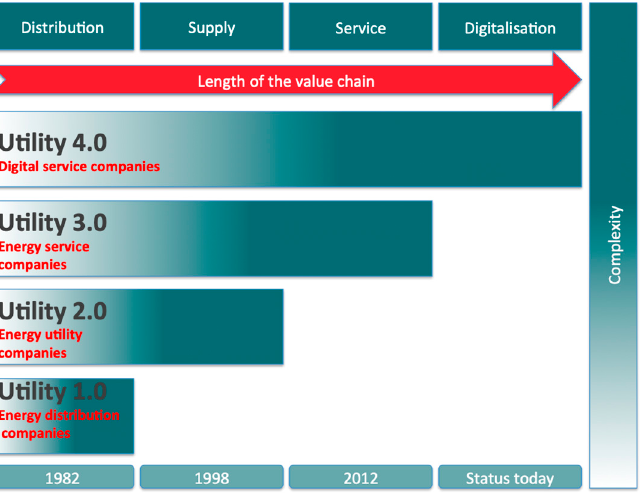
Figure 4. Changes in the roles of energy supply companies over time (authors’ illustration based on Doleski [22]).